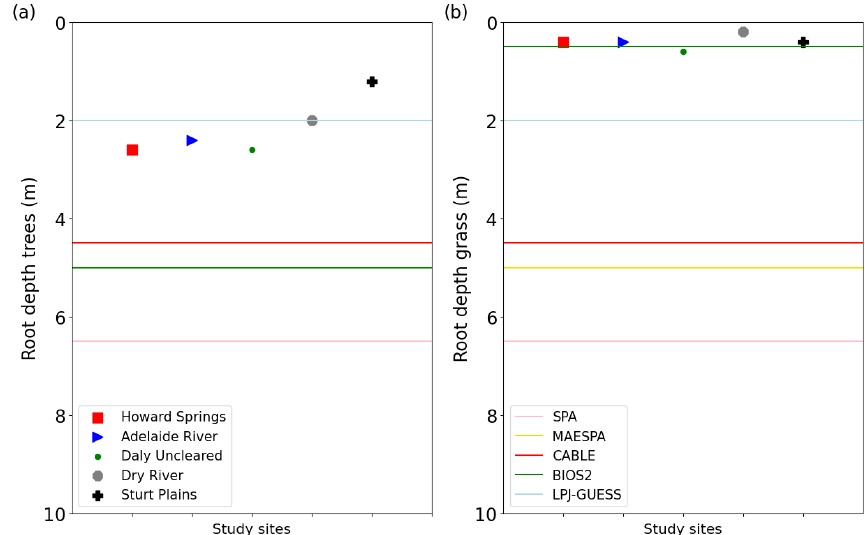
Figure 8. Modelled rooting depths for (a) trees and (b) grasses, for Howard Springs (red squares), Adelaide River (blue triangles), Daly River (green circles), Dry River (grey octagon), and Sturt Plains (black cross). The coloured lines represent the rooting depths of the models used in Whitley et al. (2016) with SPA (blue), MAESPA (orange), CABLE (green), BIOS2 (red) and LPJ-GUESS